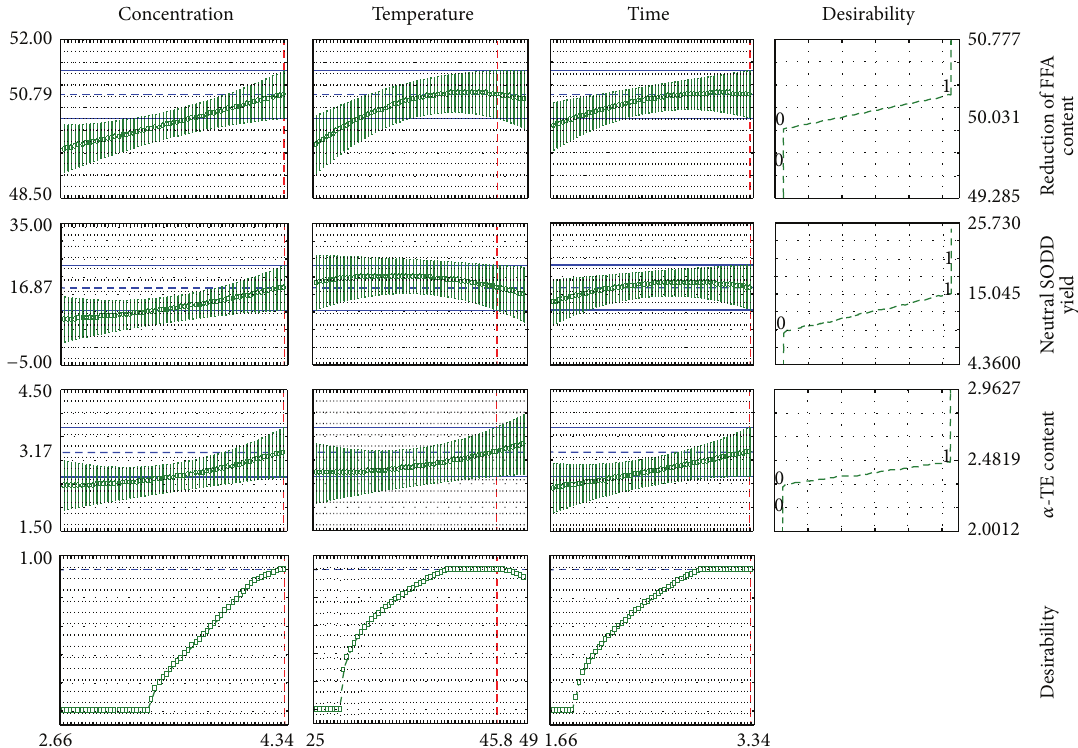
Figure 3: Predicted values and desirability analysis of the dependent variables in the second experimental